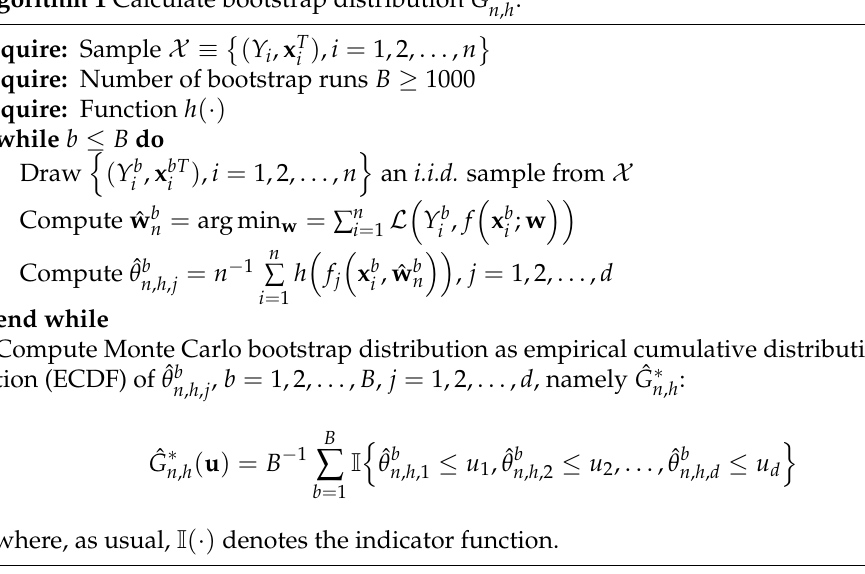
Algorithm 1 Calculate bootstrap distribution ˆ G ∗